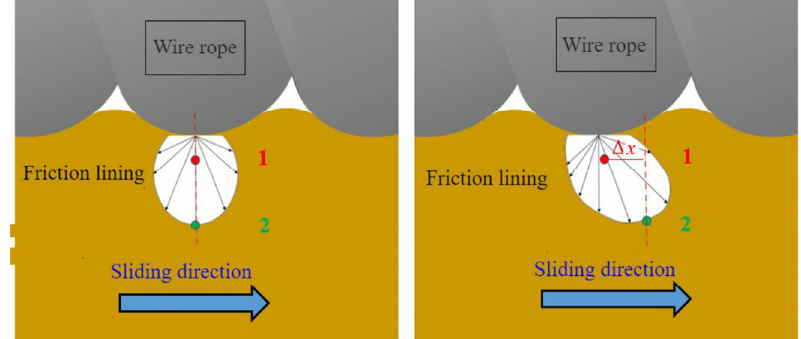
Fig. 14 Schematics of the hysteresis friction